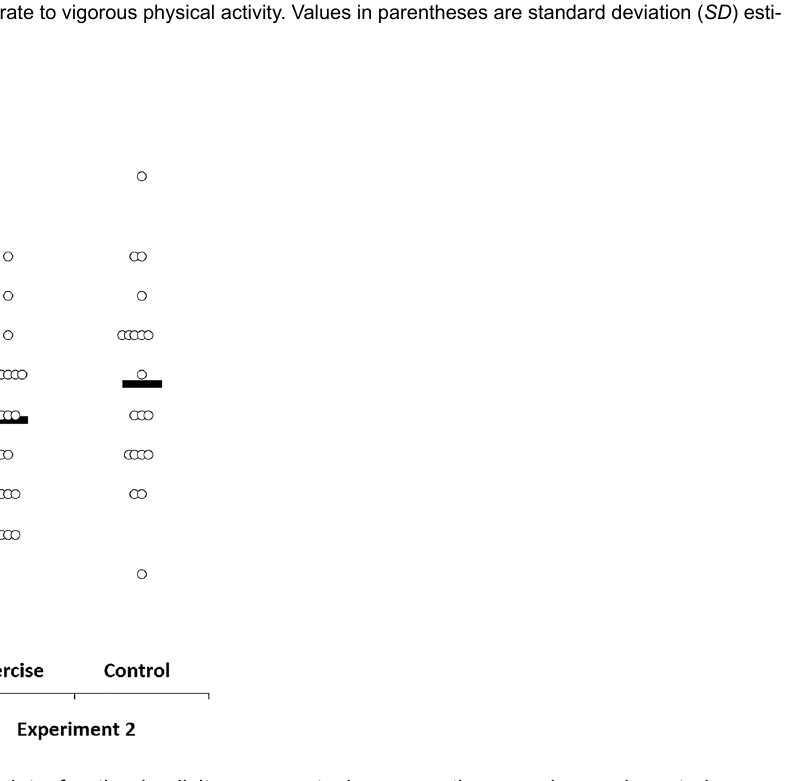
Figure 1. Mean and individual data points for the implicit memory task among the exercise and control groups for Experiments 1 and 2.